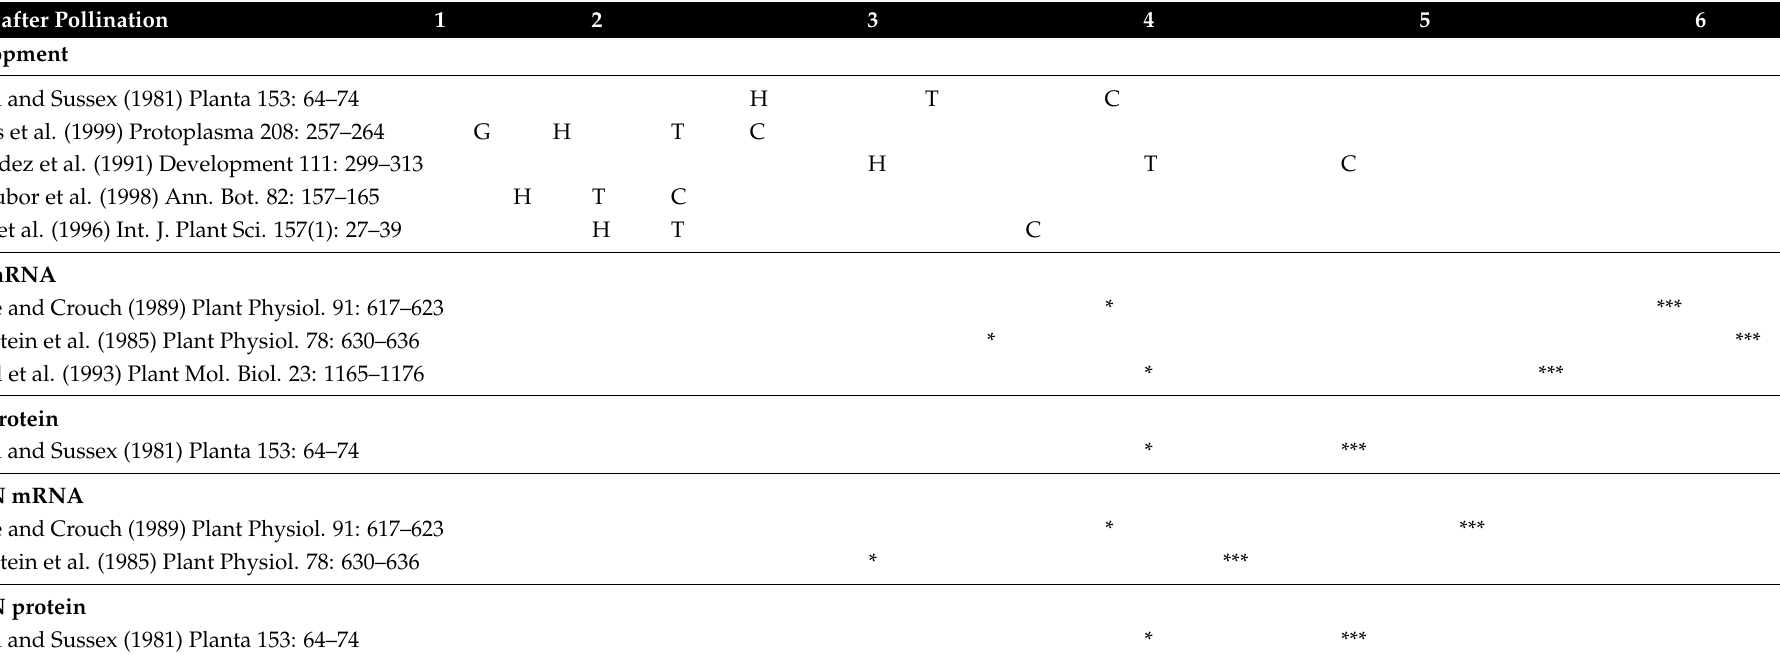
Table 3. Coincidence of zygotic embryogenesis stages in spring Brassica napus L. with spatial-temporal patterns in the accumulation of seed storage protein transcripts and gene products during the first six weeks seed of development under controlled growth environment conditions. Abbreviations are as follows: G, globular stage; H, heart stage; T, torpedo stage; C, cotyledon stage; CRU, cruciferin. A single asterisk (*) indicates initial detection and three asterisks (***) indicate peak. Weeks after Pollination 1 2 3 4 5 6